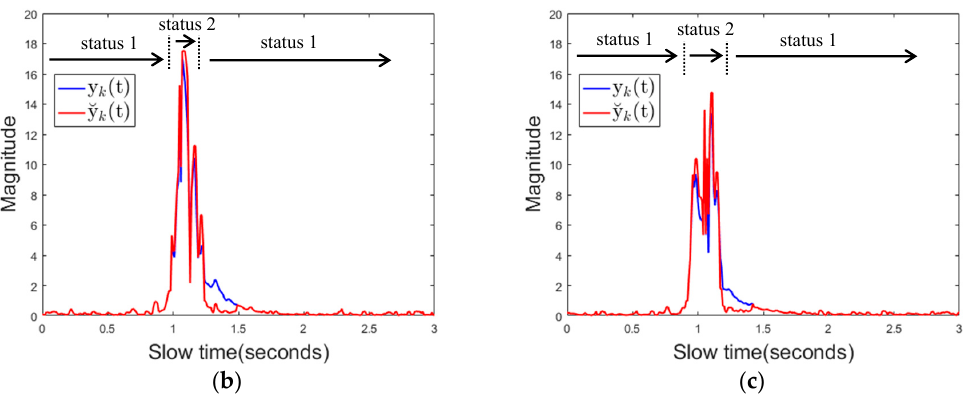
Figure 20. The maximum value of the received signal over slow time with momentary movements. ( a ) moving hand ( b ) moving water bottle ( c ) moving cell phone.